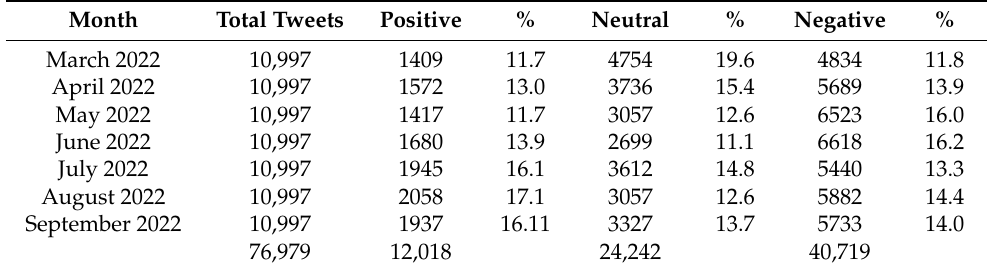
Table 1. Sentiment